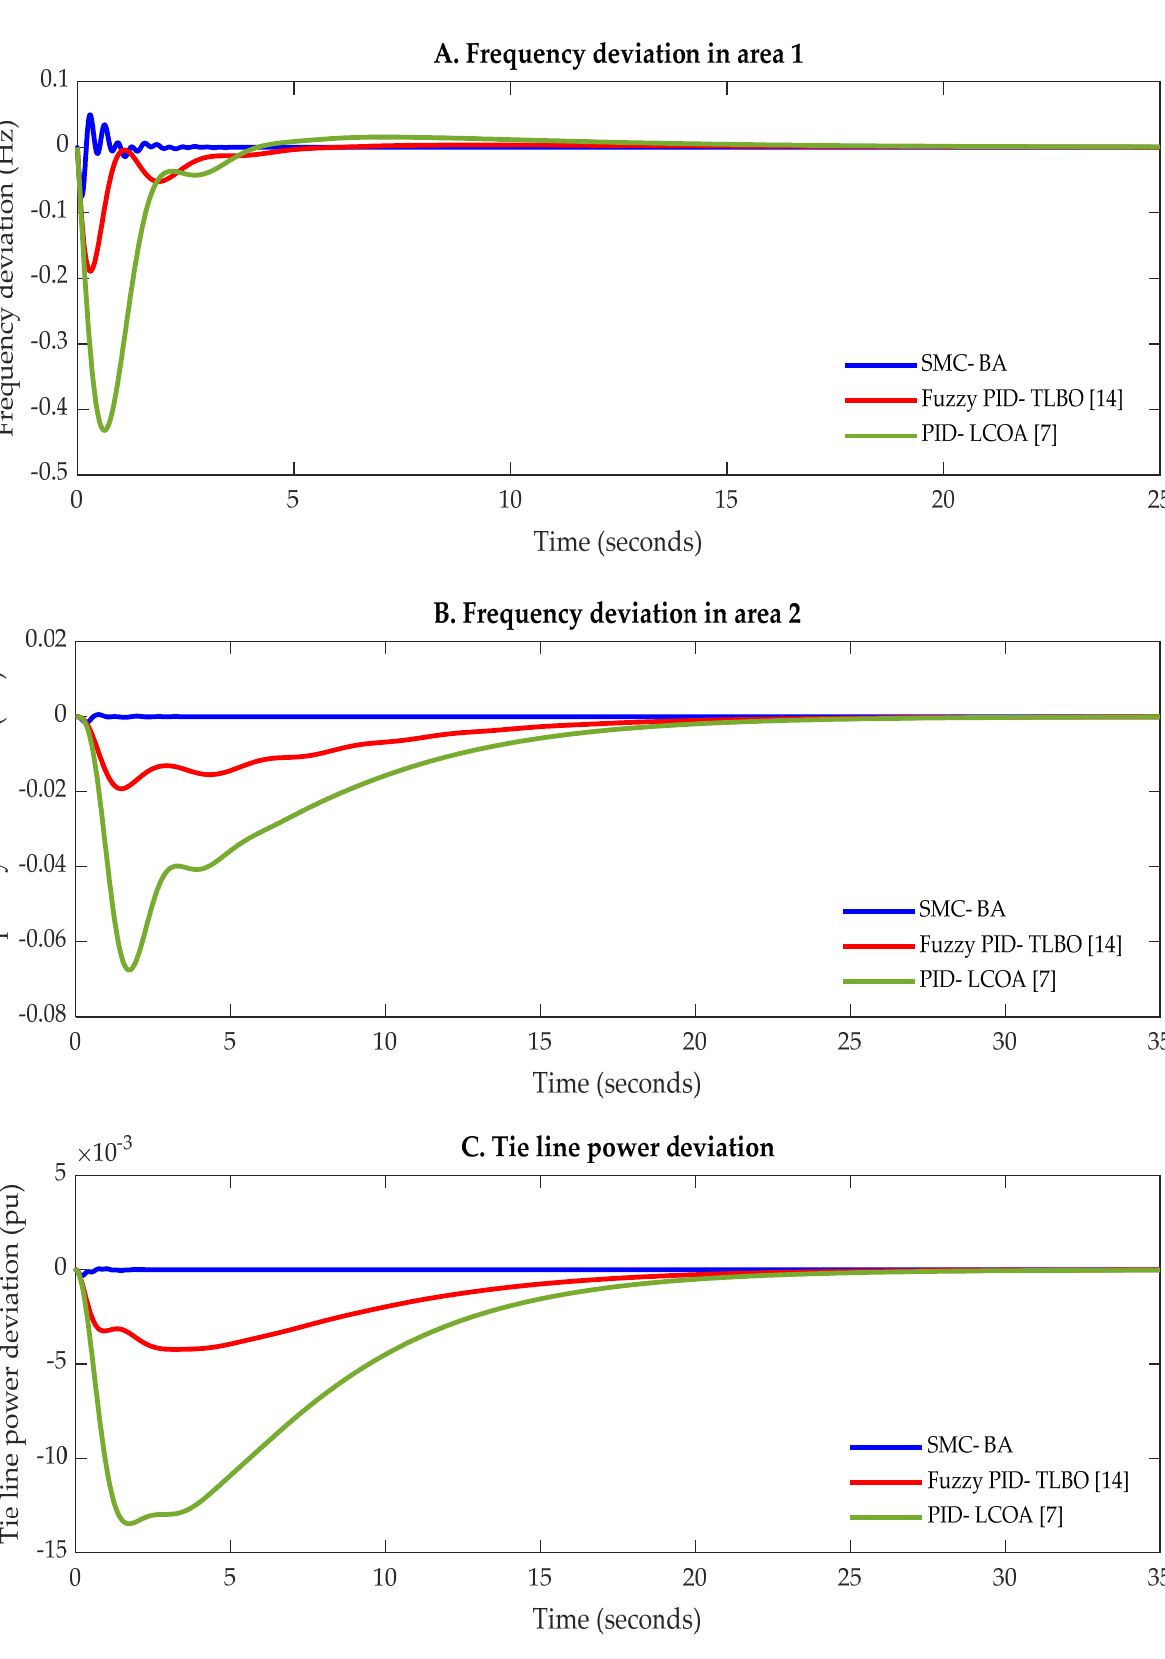
Figure 10. Dynamic response of the system with different controllers under parametric uncertainties, case 4. ( A ) Frequency deviation in area 1; ( B ) Frequency deviation in area 2; ( C ) Tie line power deviation.